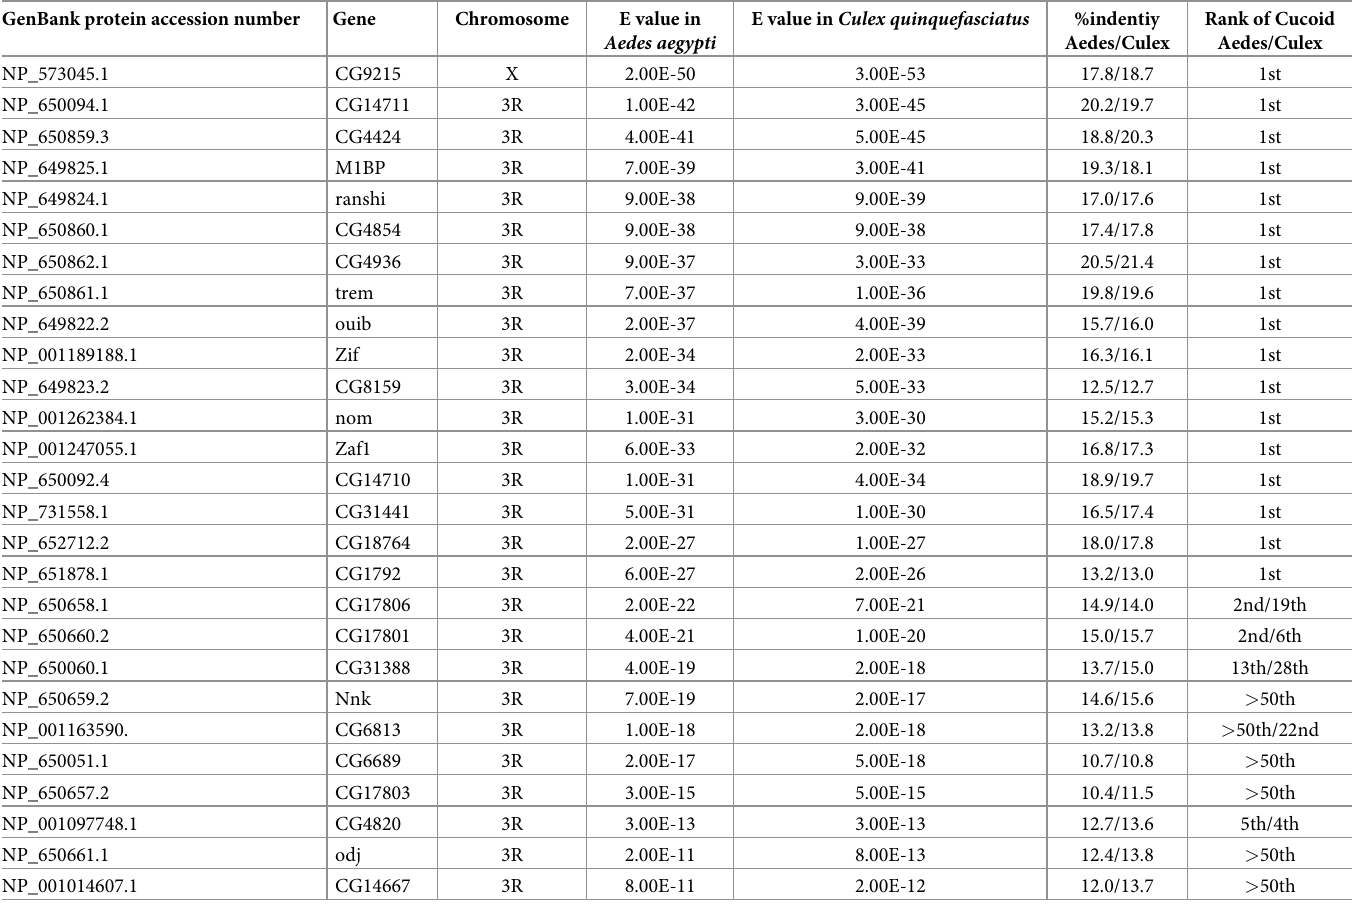
Table 1. D . melanogaster ZAD-ZNF genes in the Cucoid clade and their relationship with mosquito Cucoid in